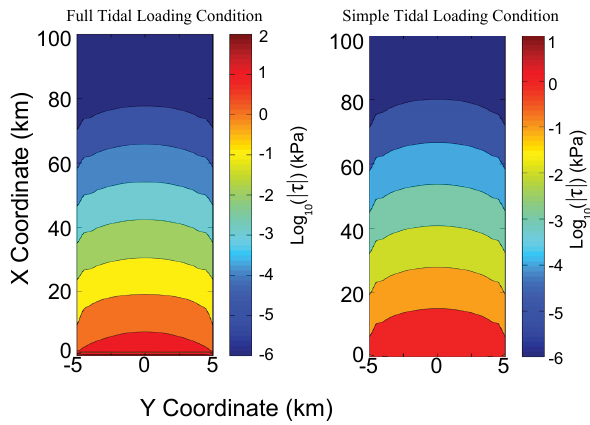
Figure C2. Comparison of the value of the longitudinal normal stress ( σ xx ) for the full tidal forcing condition (left panel) and the partial tidal forcing condition (right panel) at peak tidal amplitude. The full condition has a higher normal stress at the grounding line and a slightly more rapid decay of the stress due to the inclusion of the flexural stress. Once inland of the grounding line by 5 to 10km, the stress-transmission length scales are comparable between the two forcing